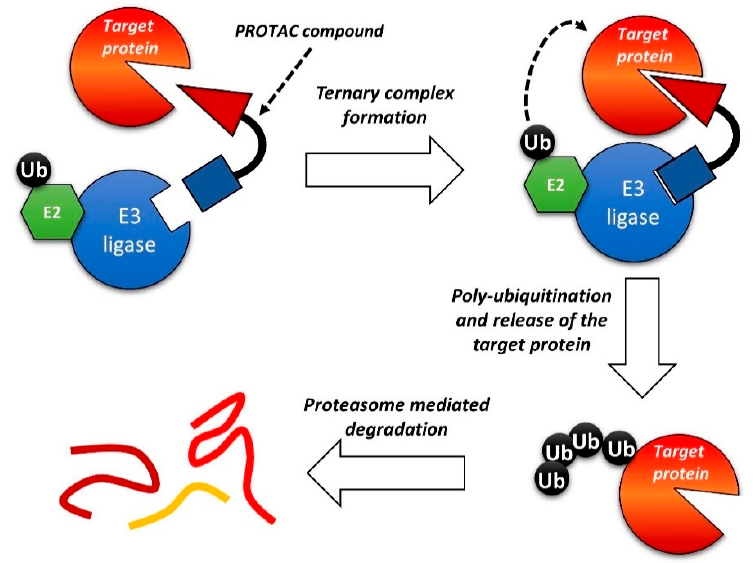
Figure 9. Schematic representation of the Proteolysis Targeting Chimeras (PROTAC) strategy. The PROTAC approach was recently applied to BCR-ABL-driven leukemia. Various